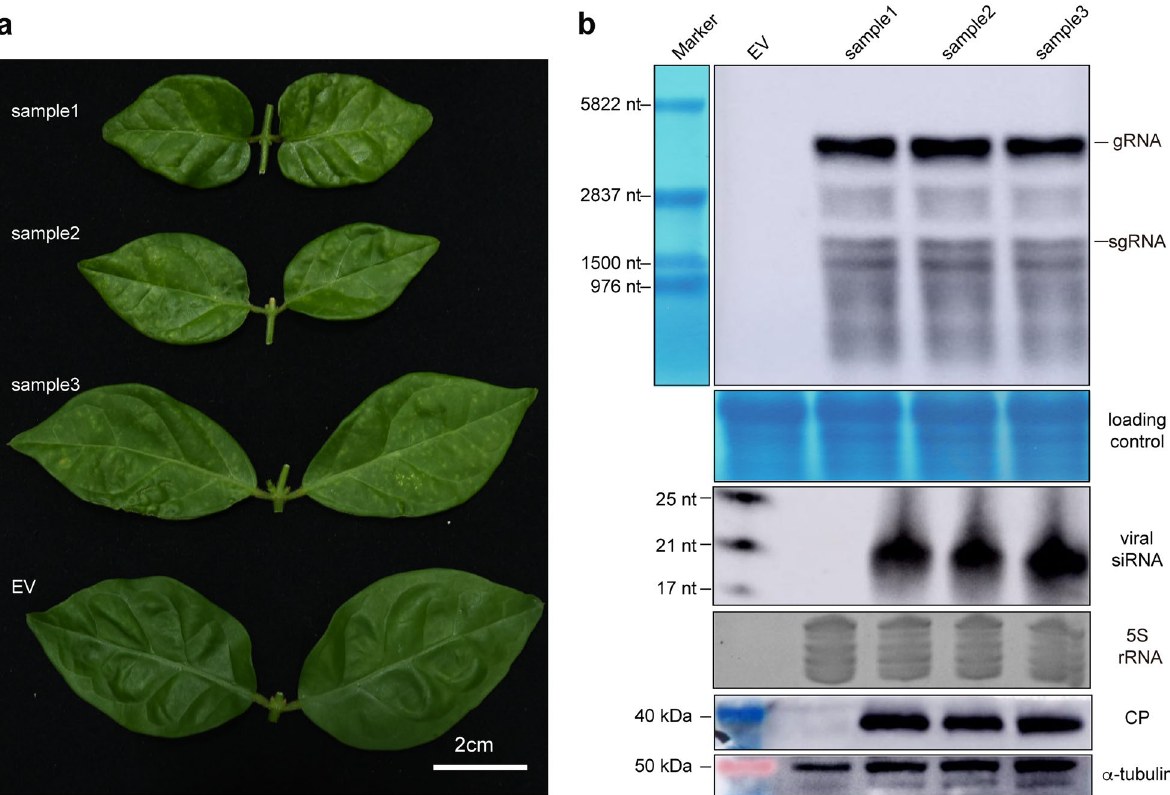
Fig. 2 Symptoms and detection of JaVH in jasmine samples. a Typical yellow spots were observed two months after mechanical inoculation with total RNA of Agro‑infiltrated Nicotiana benthamiana . b Detection of genomic RNA, subgenomic RNA, and virus derived siRNA of JaVH by Northern blotting and coat protein by Western blotting. A size marker and loading control are shown for reference